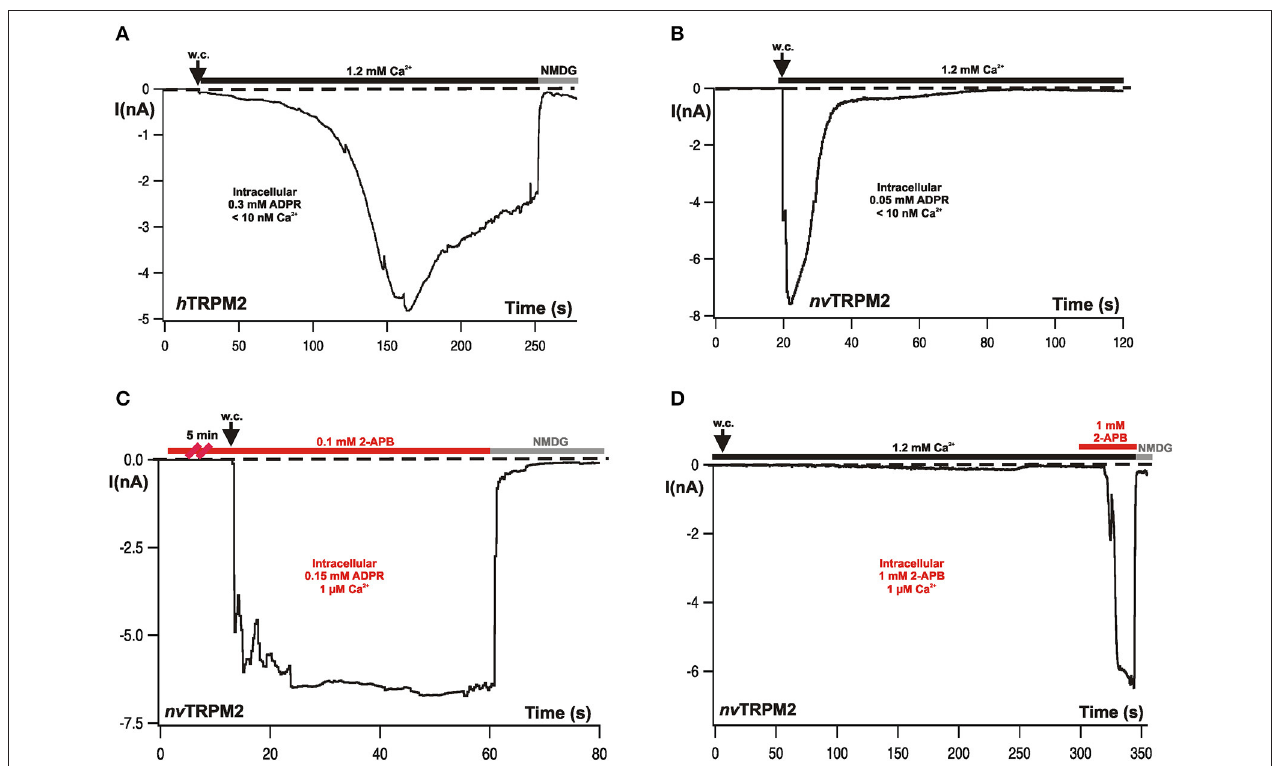
FIGURE 2 | Typical whole-cell patch-clamp recordings from h TRPM2 and from nv TRPM2 channels in HEK-293 cells. (A) Characteristic currents of h TRPM2 during stimulation with ADPR infused through the patch-pipette. Intracellular (pipette) concentrations of ADPR and Ca 2 + are indicated. Both activation and inactivation kinetics are comparatively slow. At the end of the experiment, the currents were fully blocked by a substitution of extracellular monovalent cations with NMDG. (B) Currents of nv TRPM2 in response to ADPR showing the characteristic fast kinetics of activation and inactivation. (C) Similar experimental conditions as shown before but the cells had been pre-incubated for at least 5min in bath solution containing 2-APB (0.1mM). The rapid inactivation is completely suppressed. (D) No stimulation of nv TRPM2 with 2-APB (1mM) instead of ADPR in the pipette solution. Only when applied from the extracellular side of the plasma membrane high concentrations of 2-APB ( ≥ 1mM) induces a strong and fast current activation after a characteristic delay, while inactivation does not occur. The standard Ca 2 + concentration in the bath solution for the measurements is 1.2mM Ca 2 + . Figures are slightly modified from Kühn et al. (2015, 2016,